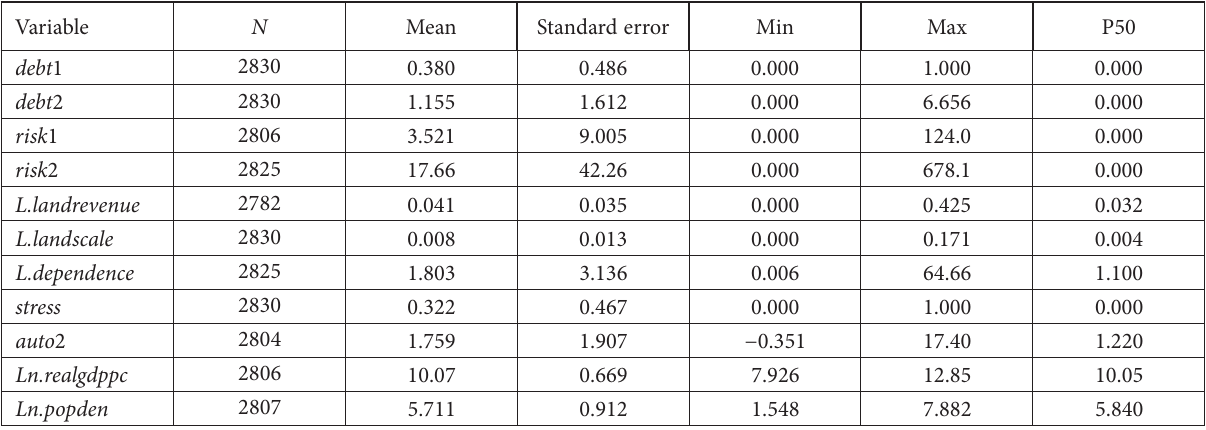
Table 1. Descriptive statistics of